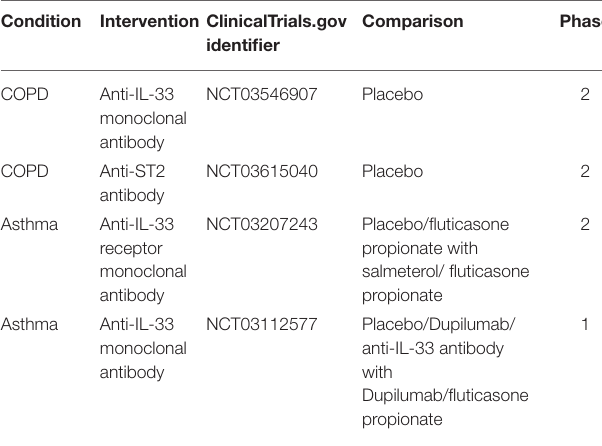
TABLE 1 | Summary of ongoing clinical trials targeting IL-33 pathway in COPD and